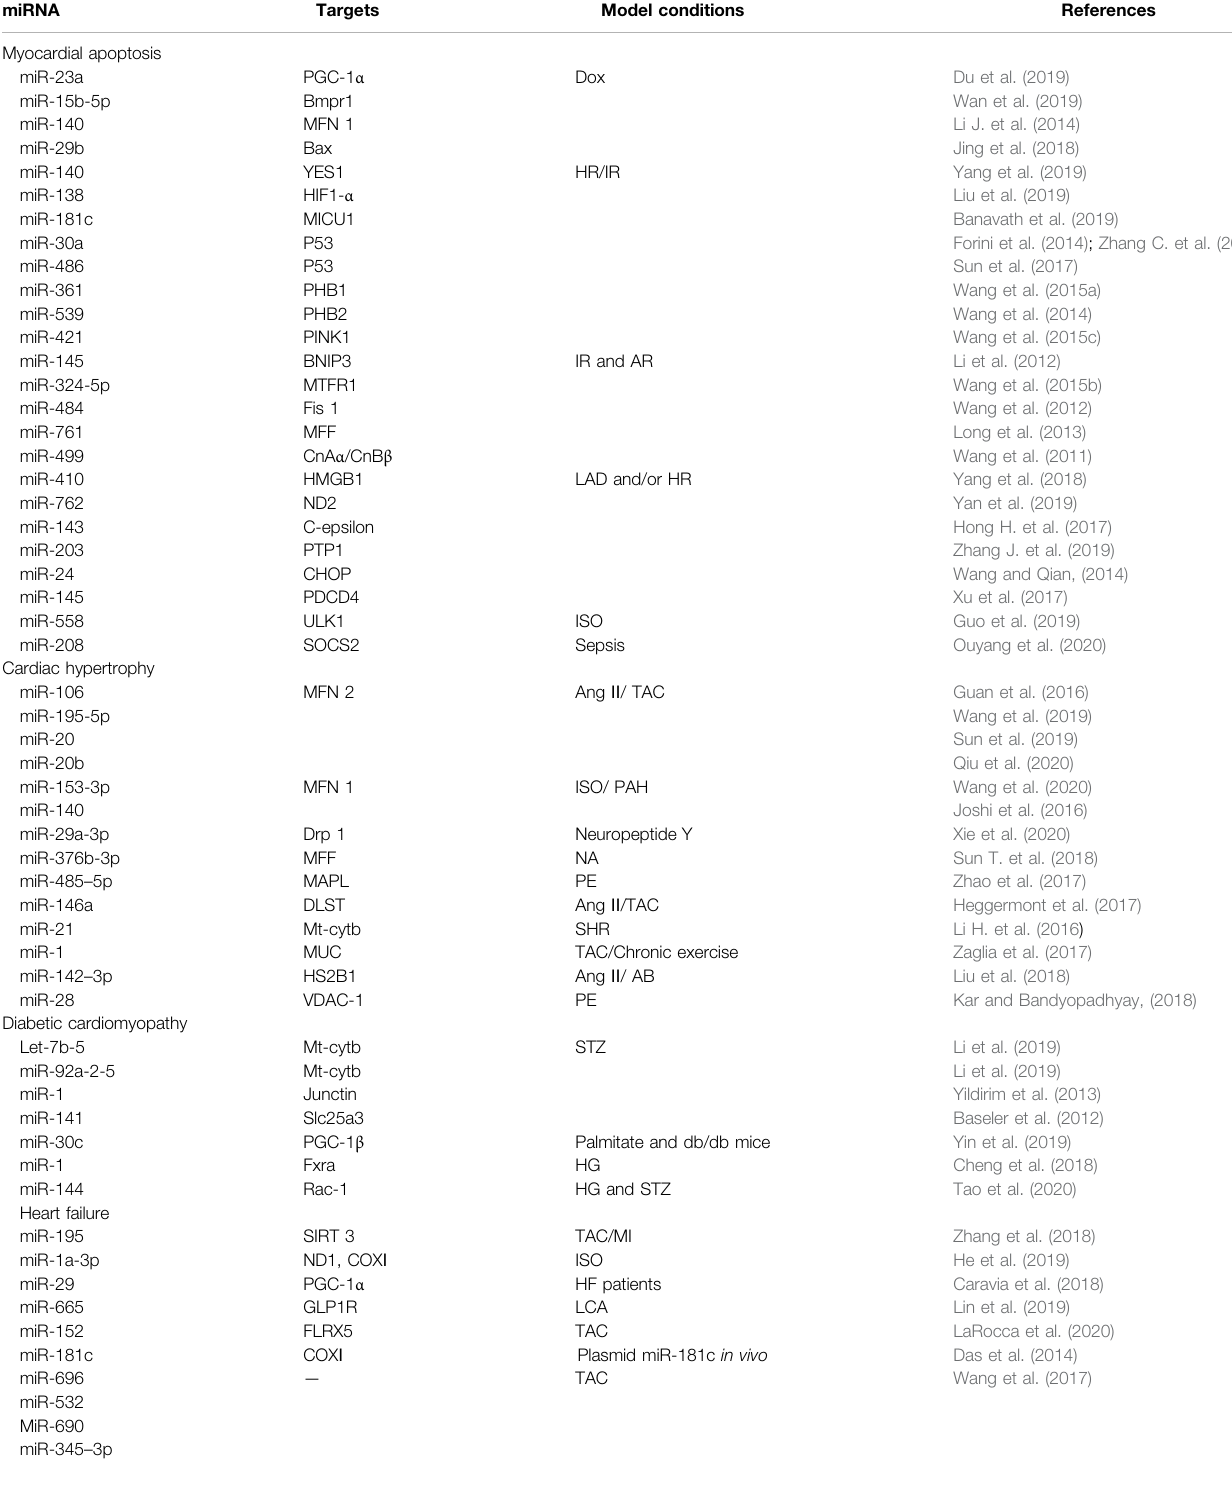
TABLE 1| MiRNAs involvedincardiac disease.Overview ofthemitochondrial functionsregulatedbymiRNAs inseveraldifferentcardiac phenotypes (myocardial apoptosis, cardiac hypertrophy, diabetic cardiomyopathy, and heart failure). miRNA